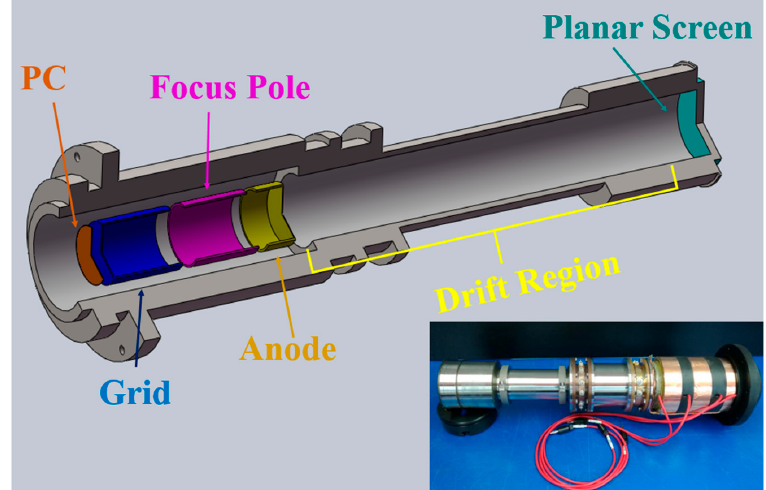
Figure 1. Relationship between the image filed angle and the field curvature: the solid line represents the electron track of the large image field angle and the Petzval image plane, while the dotted line corresponds to the small one (The red line represents the envelope diagram of the electron beam trajectory emitted by the object point on the axis, the green and blue represent the emission of the off-axis object point respectively, wherein the green represents the object point emitted on the positive half axis, and the blue represents the object point emitted on the negative half axis).